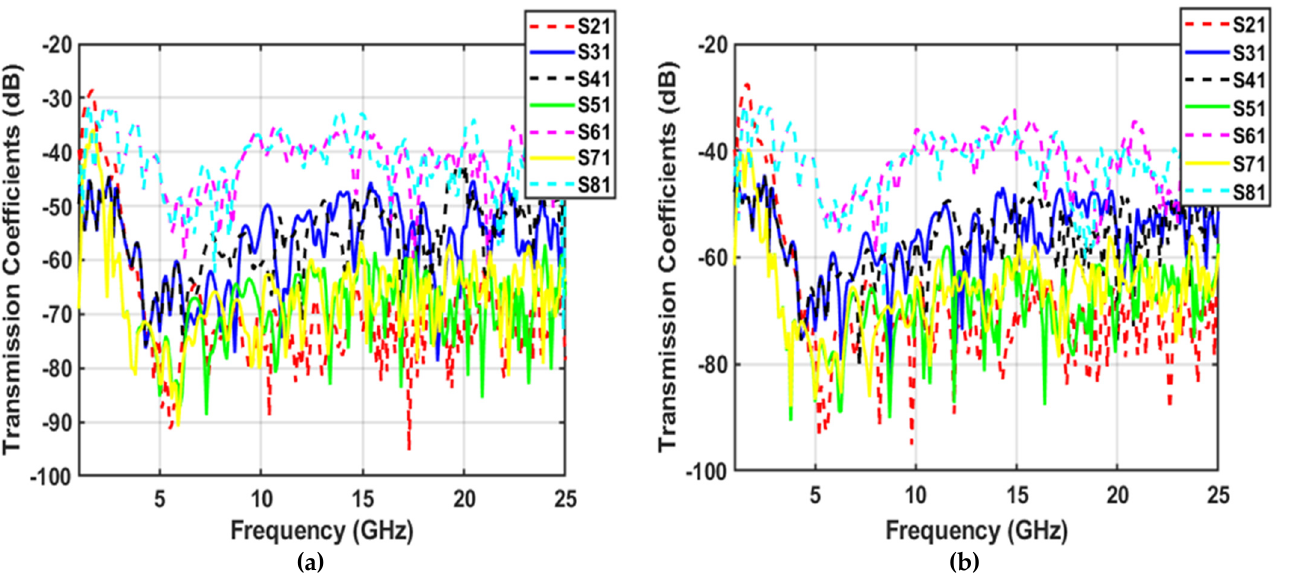
Figure 6. Mutual coupling between eight array elements: ( a ) With tumor; ( b ) Without tumor.